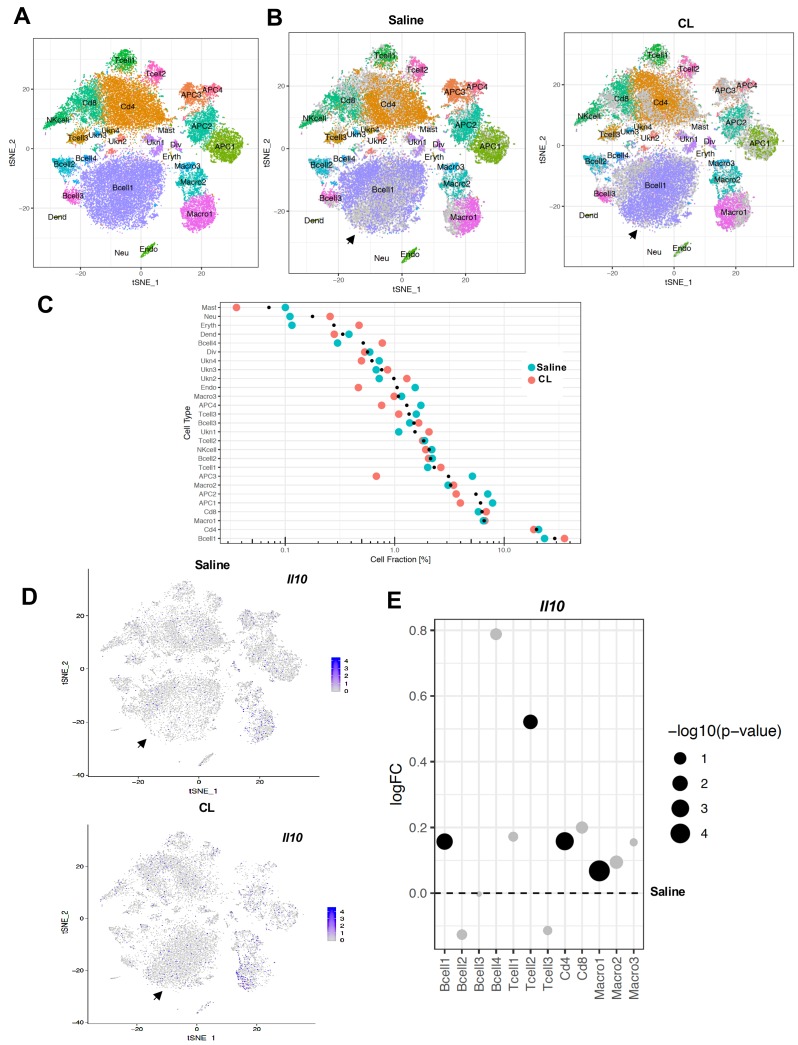
scRNA-Seq reveals an increase in adaptive immune cells under adrenergic stress.(A) Aggregated tSNE-plot of combined ~10,000 SVF cells isolated from iWAT of mice treated with CL or saline for 4 days. Colored dots are cells assigned to clusters based on similar transcriptomic signatures and these clusters correspond to specific cell-types. (B) Segregated tSNE-plot from (A) showing percentage of cell-types between control (Saline) and β3-agonist CL-treated mice. The tSNE-plot also shows differences in percentage of clusters between control and CL-treated mice. Black arrows indicate major B-cell population. (C) Colored dot plot showing percentage of fractions plotted in y-axis and cell types in x-axis under indicated conditions. (D) tSNE-plot showing cells expressing Il10 in control and CL-treated mice. Black arrows indicate major cell clusters with Il10 expression. (E) Dot plot showing expression levels of Il10 in indicated cells comparing control and CL-treated mice. The Log2Fold Change (FC) ratio of saline vs. CL was plotted as a function of log10 p-value and indicated as different sizes of dots. Fold-change and p-value was compared with saline condition represents as a dotted line.